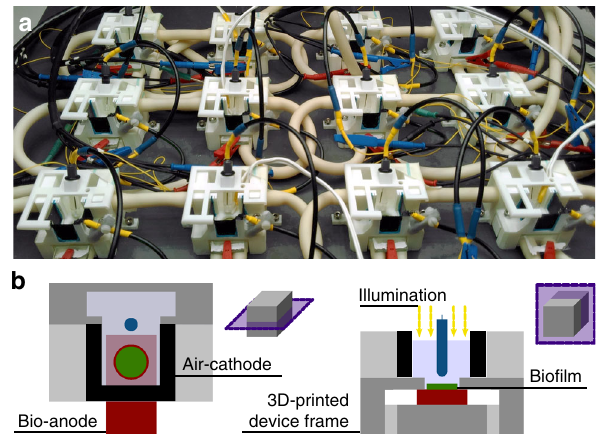
Fig. 3 Design of biophotovoltaic devices. a Assembled and connected 3D- printed devices, incl. reference electrodes with with blue connectors, positioned in the homogeneous illumination area. b Two schematic perspectives of cuts through a device indicating the locations of electrodes and bio fi